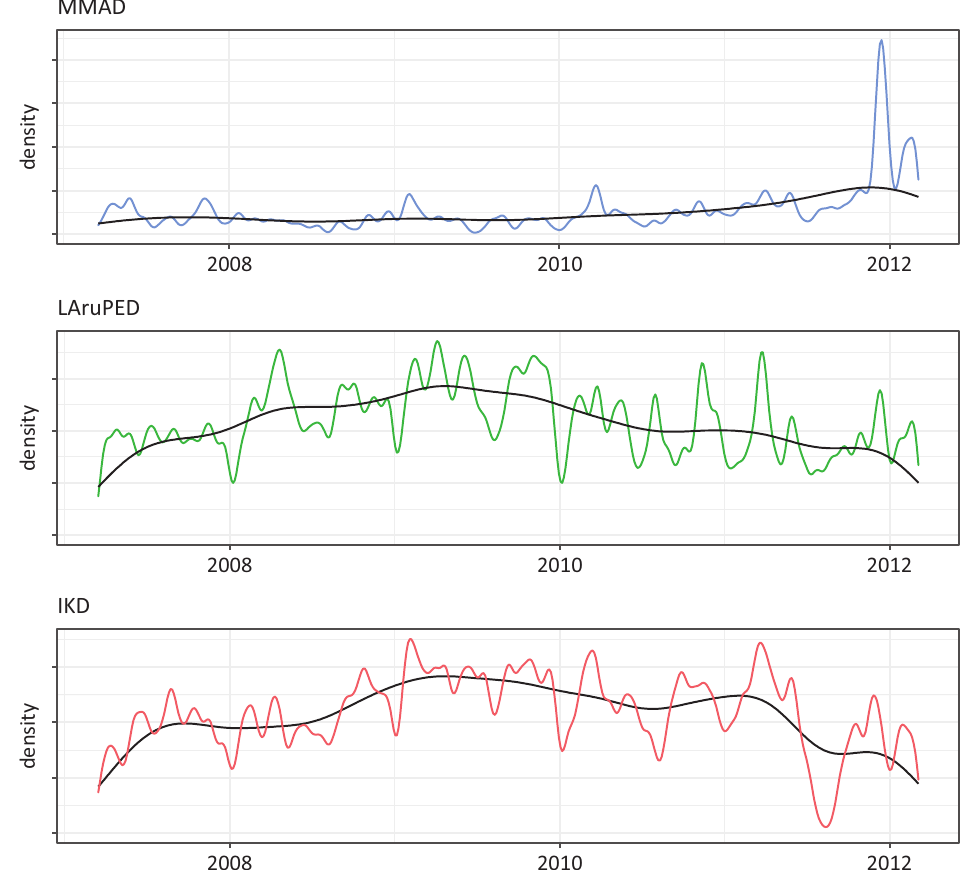
Figure 1. Protests events over time by data source, with density curve and trend line (March 2007–March 2012). Media and Communication, 2021, Volume 9, Issue 4, Pages